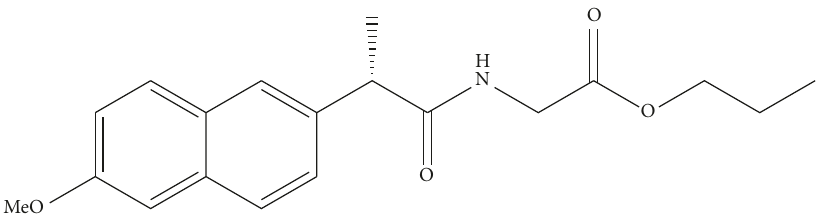
Figure 2: Chemical structure of